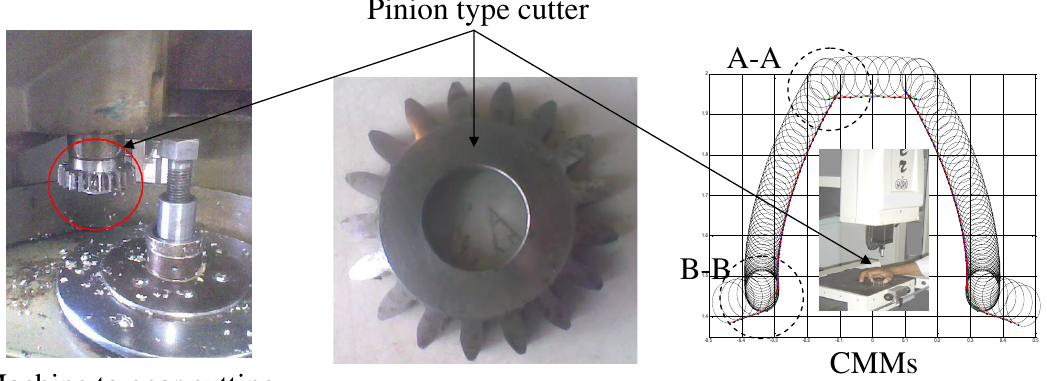
Fig. 1. (Color online) The data input from